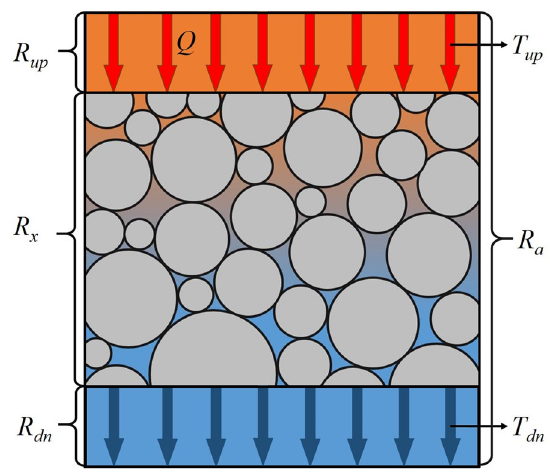
Figure 2 Thermal resistance composition of the sandwich